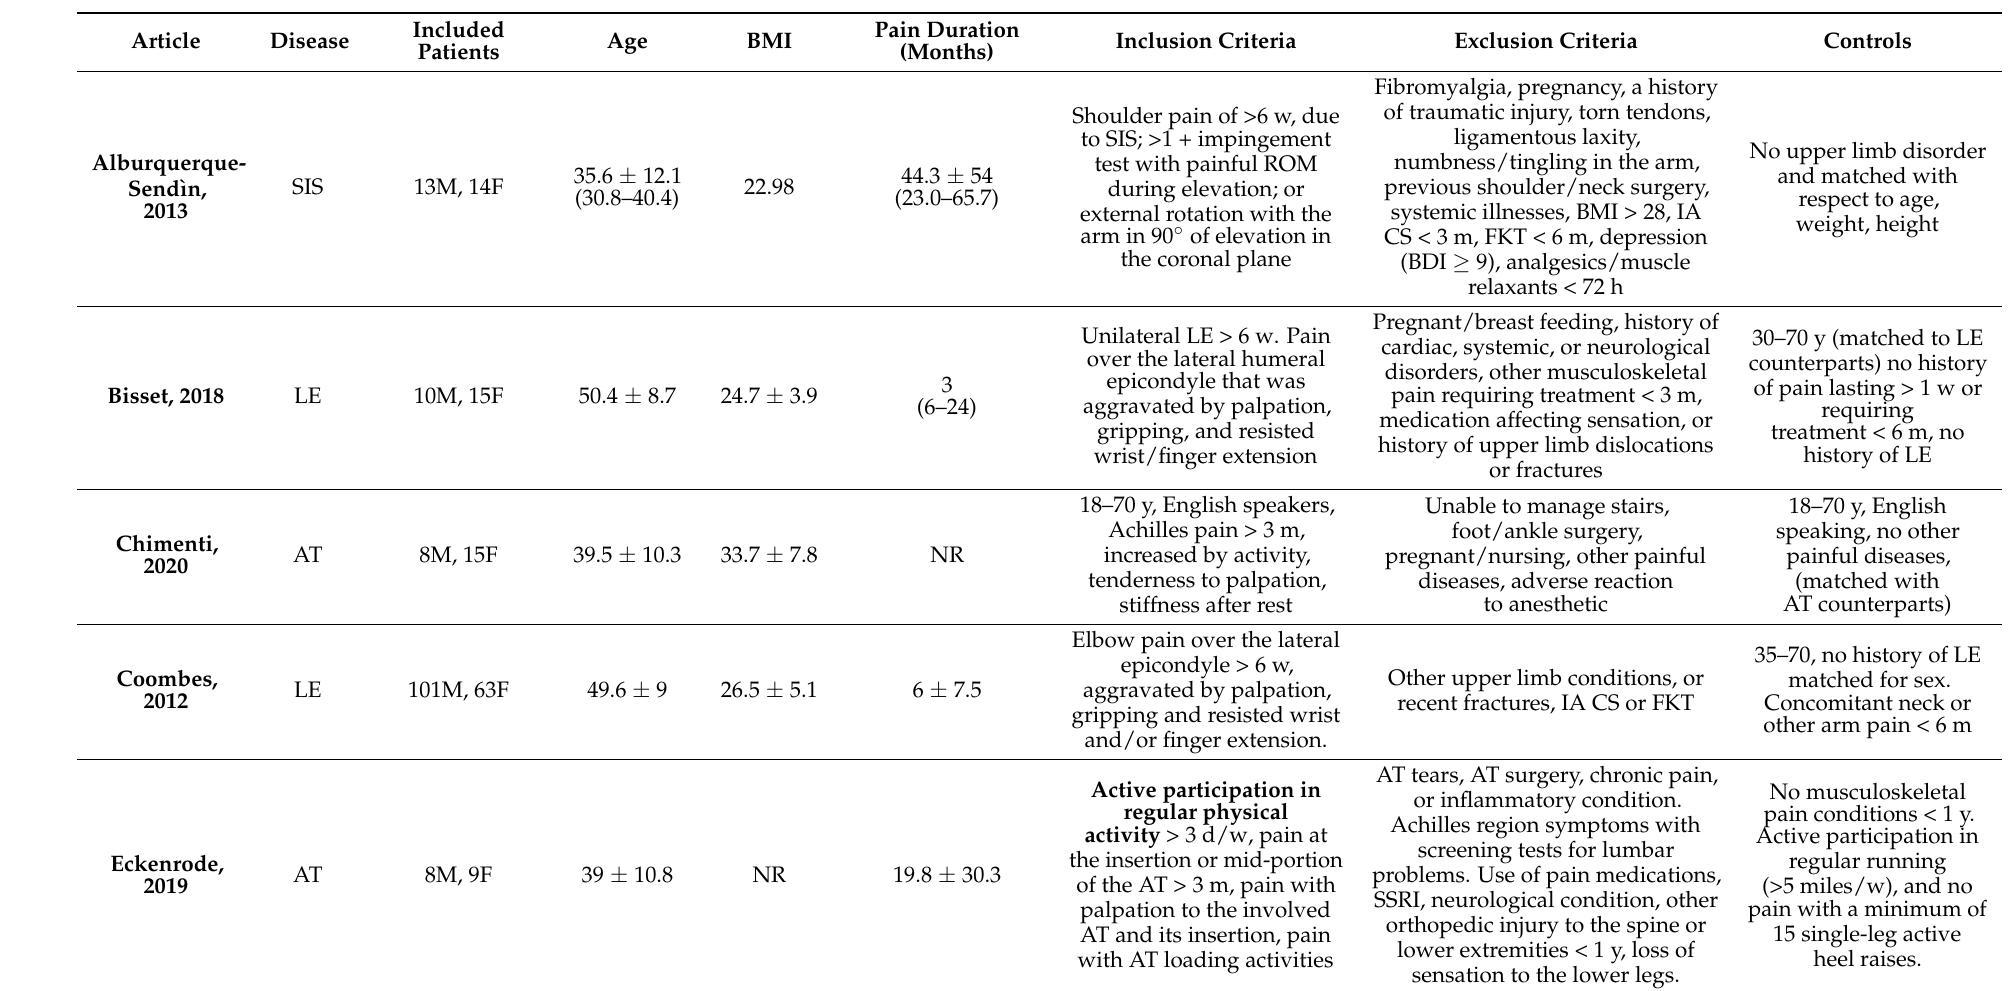
Table 1. Characteristics of the included studies and